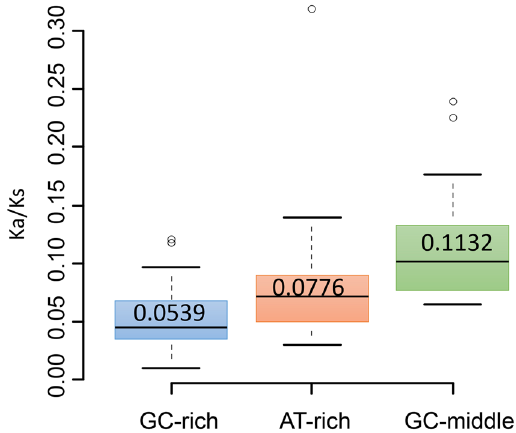
Figure 4. Average Ka/Ks for groups of genomes with different GC contents. The boxplot of Ka/Ks for GC-rich organism (GC content > 64%), AT-rich genomes (GC < 32%) and GC-middle genomes (GC content: 47% ~53%). The mean Ka/Ks for the three groups are: 0.0539, 0.0776 and 0.1132. The student’s t test showed that the GC-rich group and AT-rich group are significantly lower than the GC-middle group ( P = 4.111e-07). The increase in Ka/Ks ratio may be an evidence of the relaxation of negative